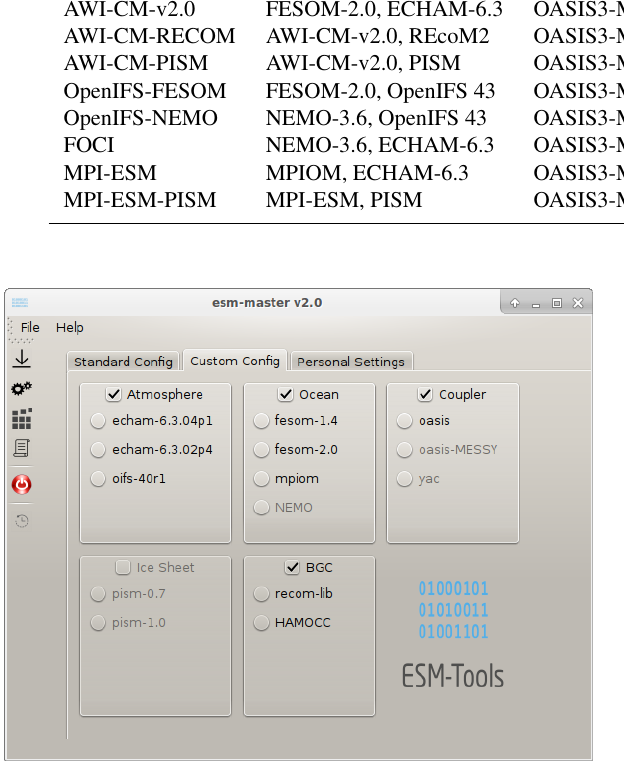
Figure 8. GUI for ESM-Tools, which helps to download, compile and configure selected